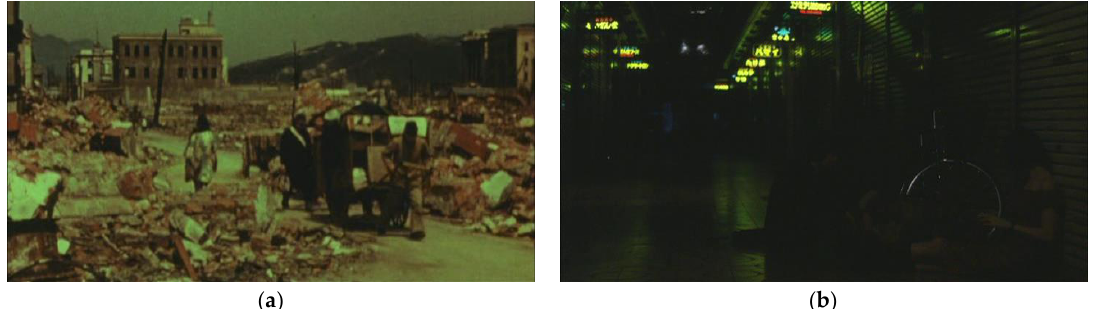
Figure 5. Frames from H Story . A panoramic view of the ruins of the recently bombed Hiroshima ( a ) followed by a shot of Dalle and Machida walking along the city in present ( b ). Source: DVD edition by Cinéma Indépendant (France).